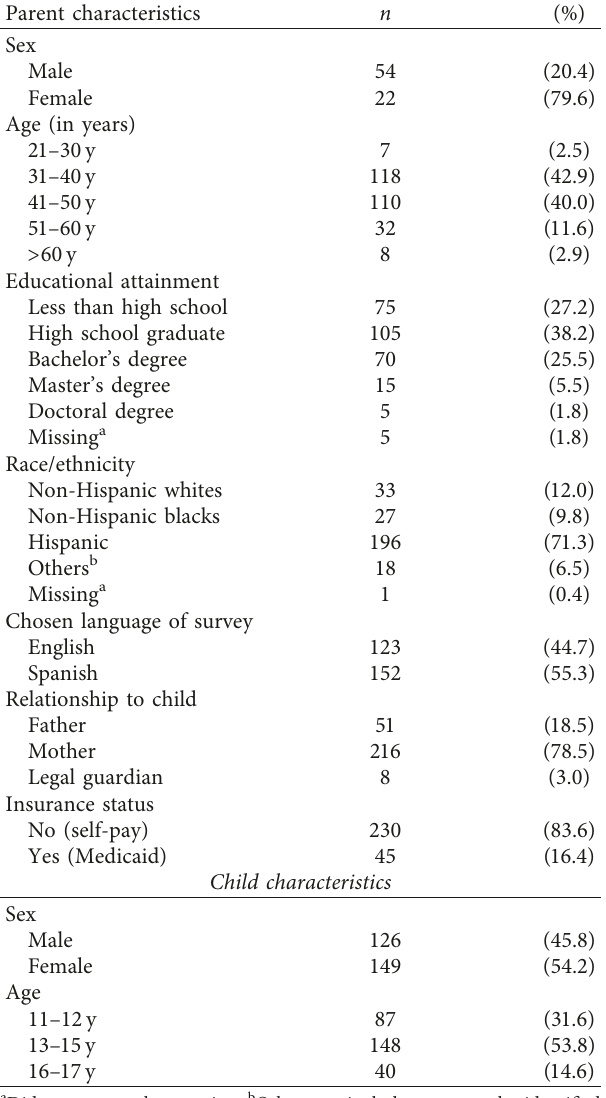
Table 1: Parent and children demographic characteristics ( N �